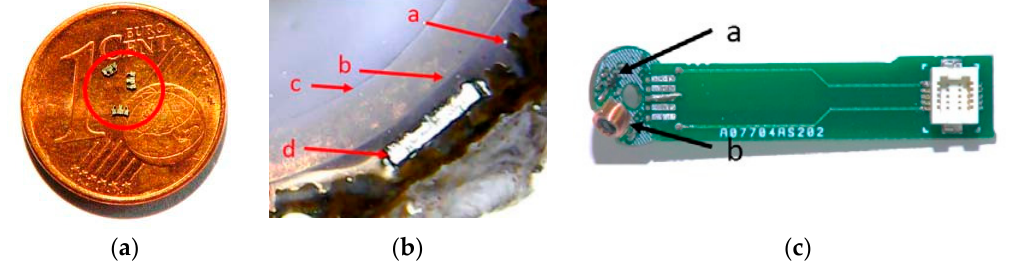
Figure 3. ( a ) A set of different laser cut markers on top of a Eurocent coin to illustrate marker size; ( b ) Marker mounted on ciliary processes of a Rhesus monkey eye. With a . corpus ciliary; b . equator lens; c . anterior capsule and d . top view of the marker. ( c ) With a . NESG2046M33 based Colpitts oscillator and b . the wire wound detection coil.